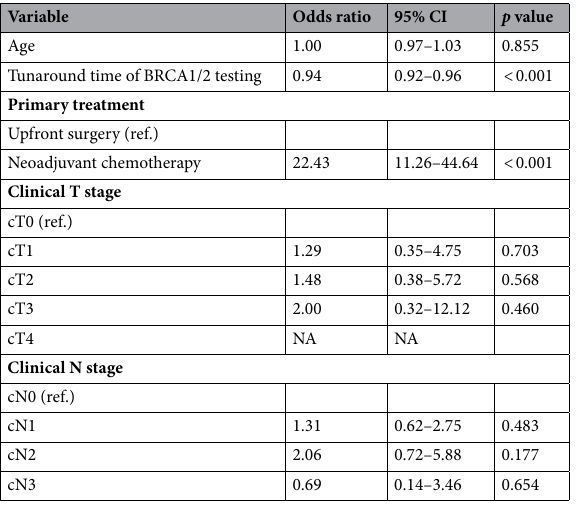
Table 2. Multivariable analysis of factors associated with BRCA1/2 mutation status known prior to surgery. Multivariable analysis was conducted by logistic regression with backward variable selection.